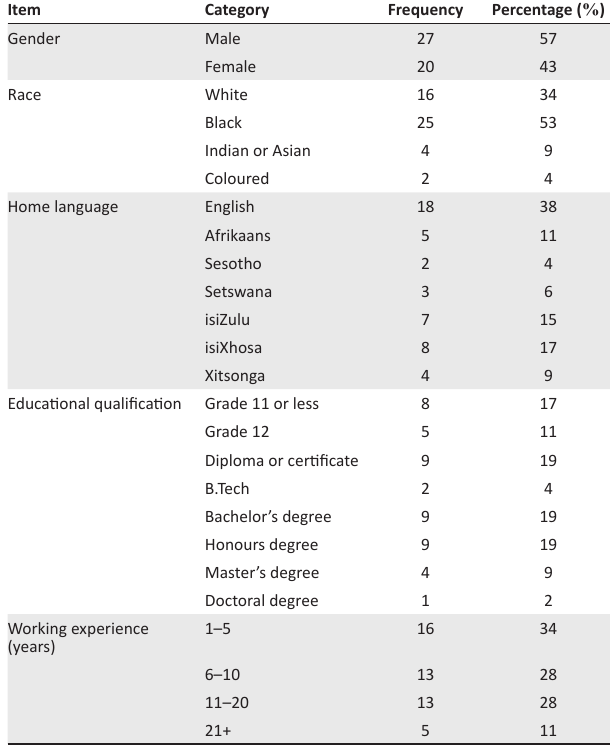
TABLE 1: Frequency distribution of participant